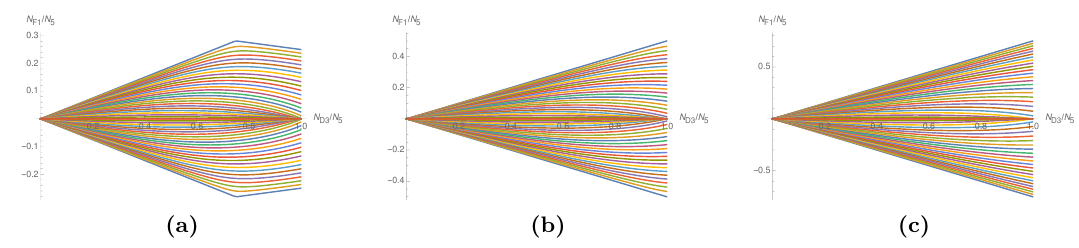
Figure 10. ( N D3 , N F1 ) charges for K/N 5 ∈ { 1